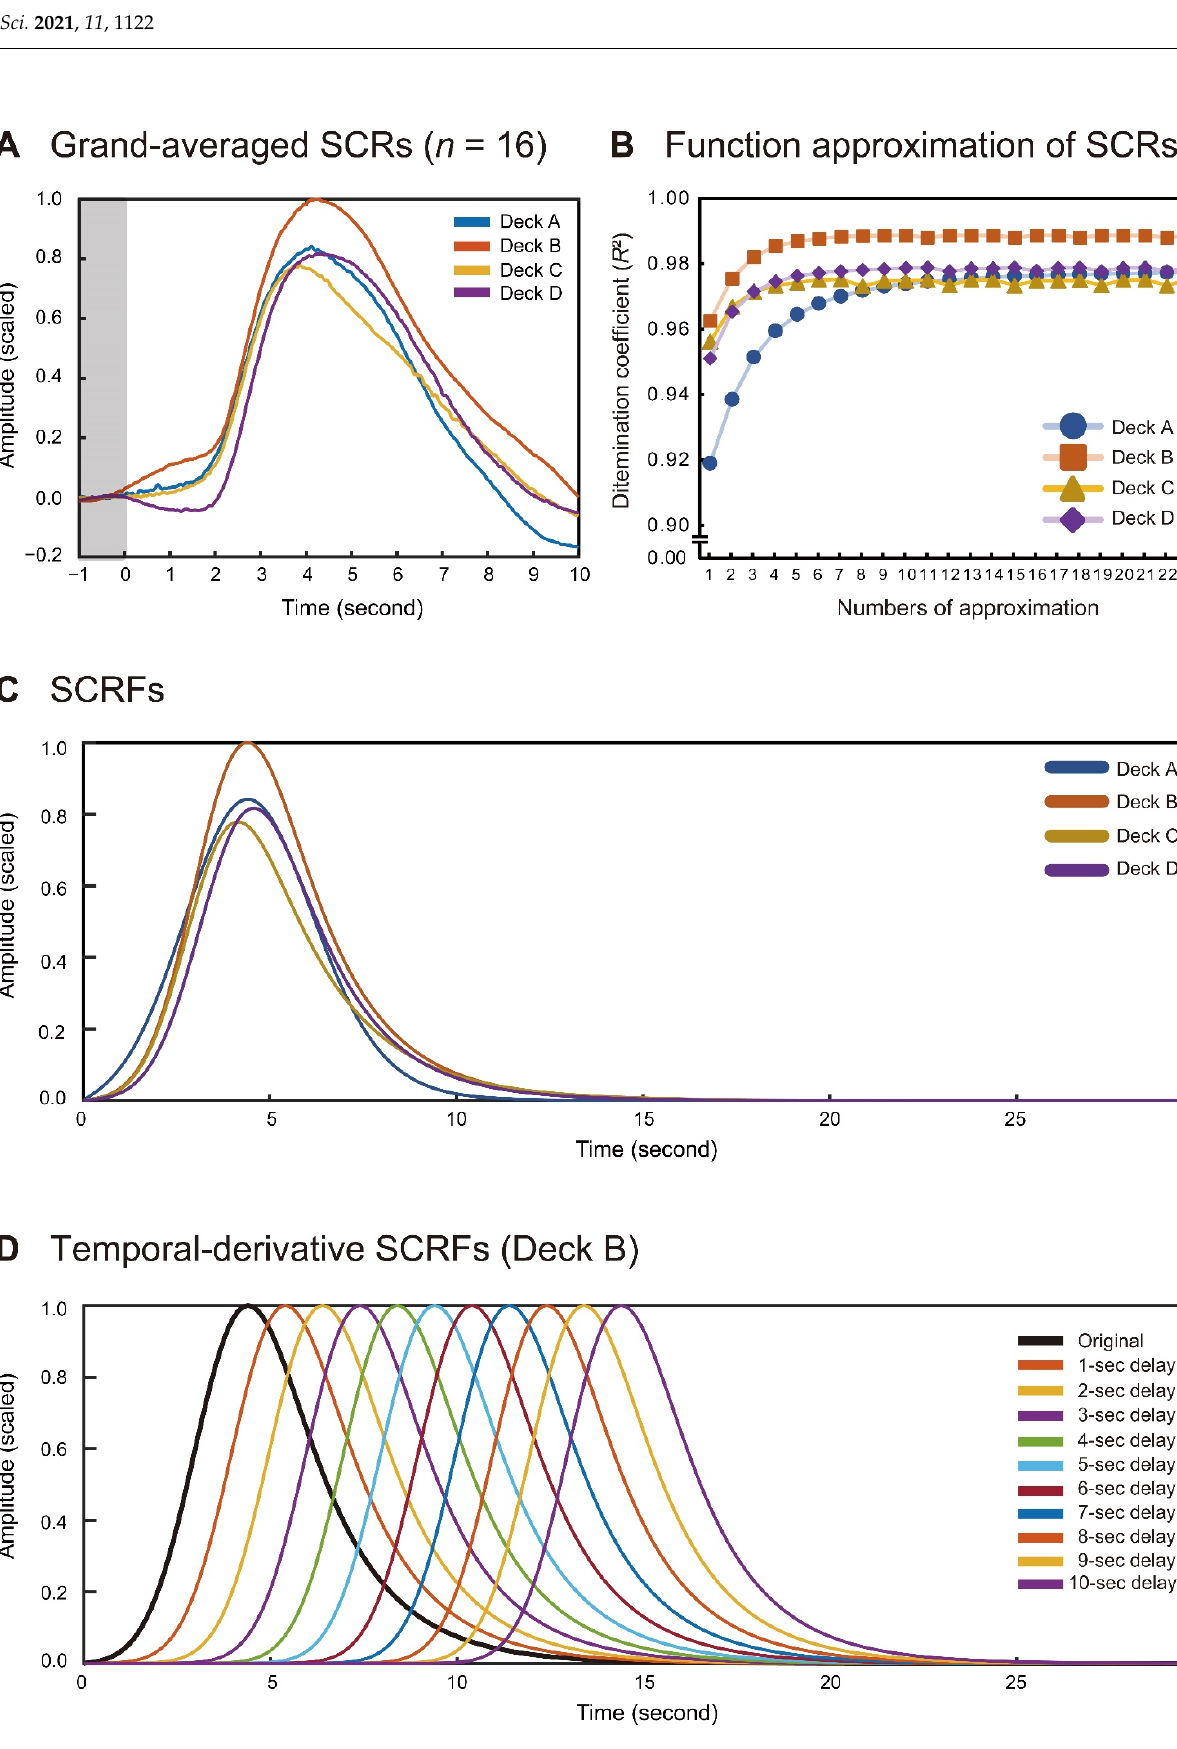
Figure 2. Comparisons of total averaged SCRs for the four card decks in Experiment 1 ( n = 16) ( A ). Transition of determination coefficients ( R 2 ) during the recursive function approximation of the original SCRs ( B ). SCRFs obtained for the four card decks ( C ) and temporal-derivative SCRFs exemplified for Deck B ( D ).